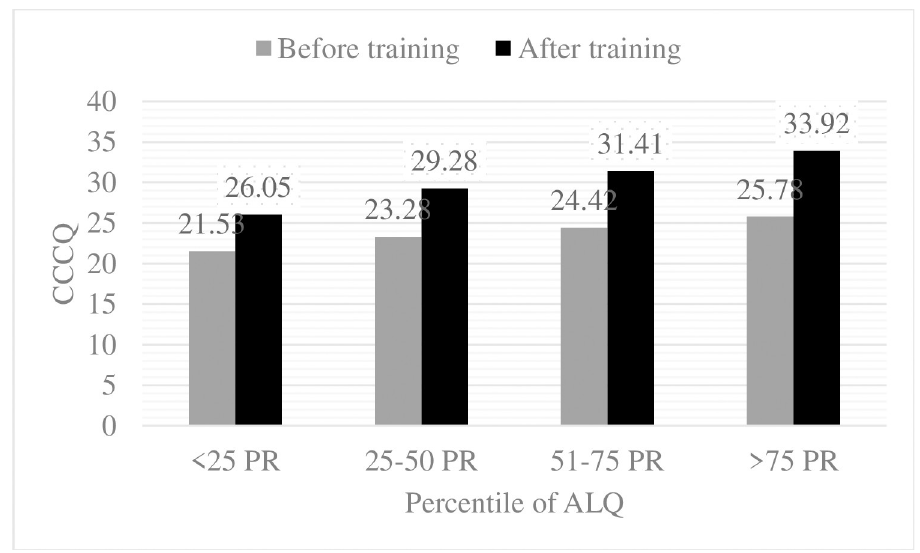
Fig 1. Change of surgical competencies by 4 levels of adult learning pattern. ALQ: Adult Learning Questionnaire; CCCQ: Clinical Core Competency Questionnaire; PR: percentile.